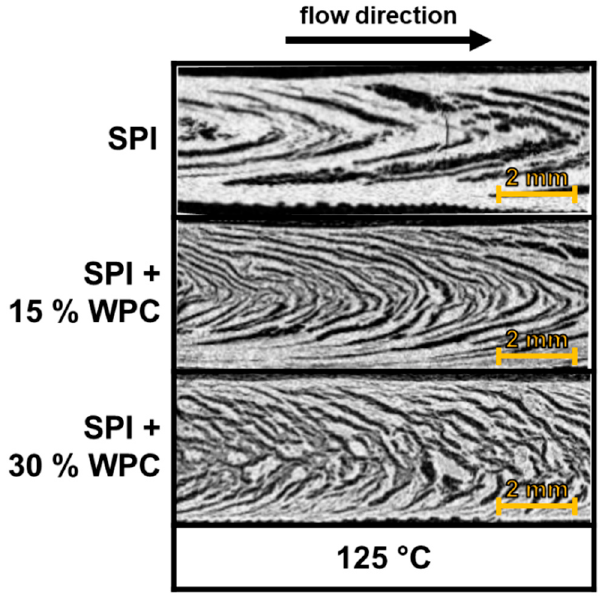
Figure 7. Multi-phase morphology, obtained through micro-CT of freeze-dried extrudates, for different protein blends (0–30% WPC) and material temperature of 125 °C.